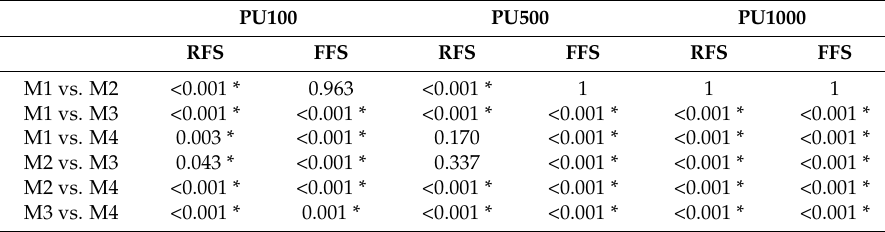
Table 5. p -values of the pair-wise Wilcoxon test; significant differences ( p < 0.05) between foot strike detection methods M1 to M4 were marked with *; large effects ( d ≥ 0.8) were found for all significant differences, except comparison M2 vs. M3 for PU100—RFS (trivial effect d =